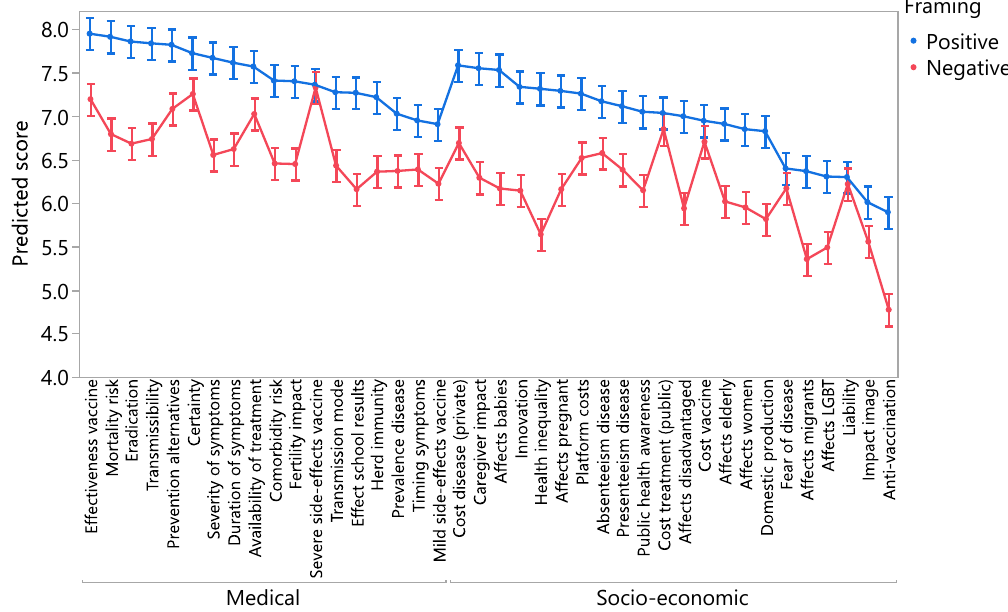
Figure 2. Predicted scores.